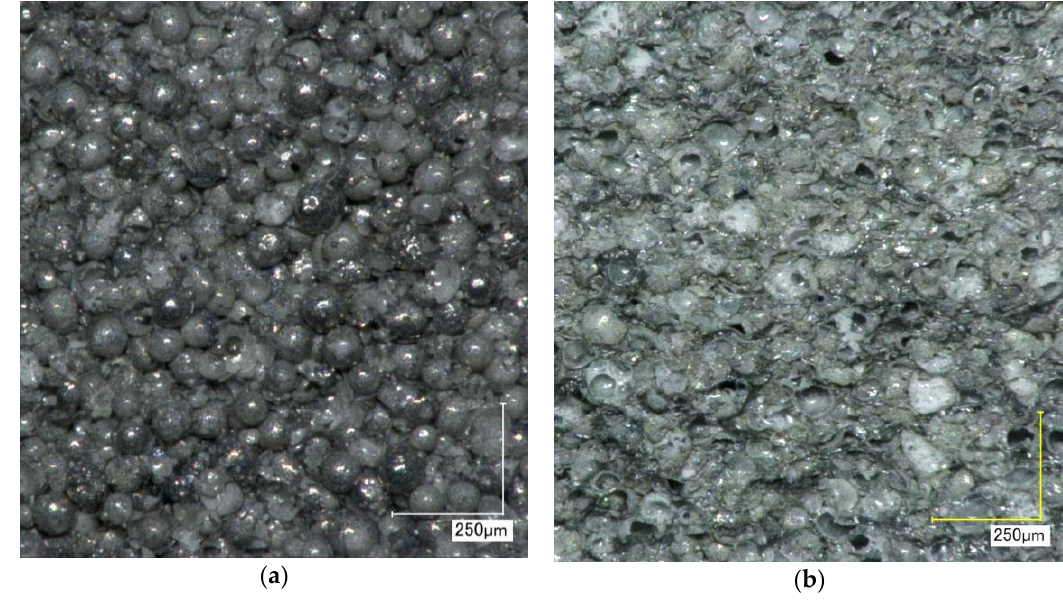
Figure 5. Early images of steel@CS materials: ( a ) Outer surface of sample sintered 4 min at 1100 °C; ( b ) Fracture surface of corresponding sample.